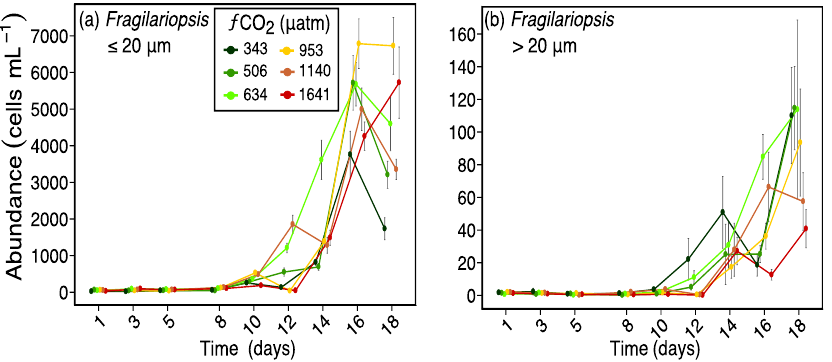
Figure 4. Abundances of (a) Fragilariopsis spp. ( ≤ 20µm in length), and (b) Fragilariopsis spp. ( > 20µm in length) over days 1 to 18 of the incubation of a natural protistan community in tanks maintained at different f CO 2 levels. Error bars are standard errors derived from pseudo-replicates undertaken at each time point for each treatment.